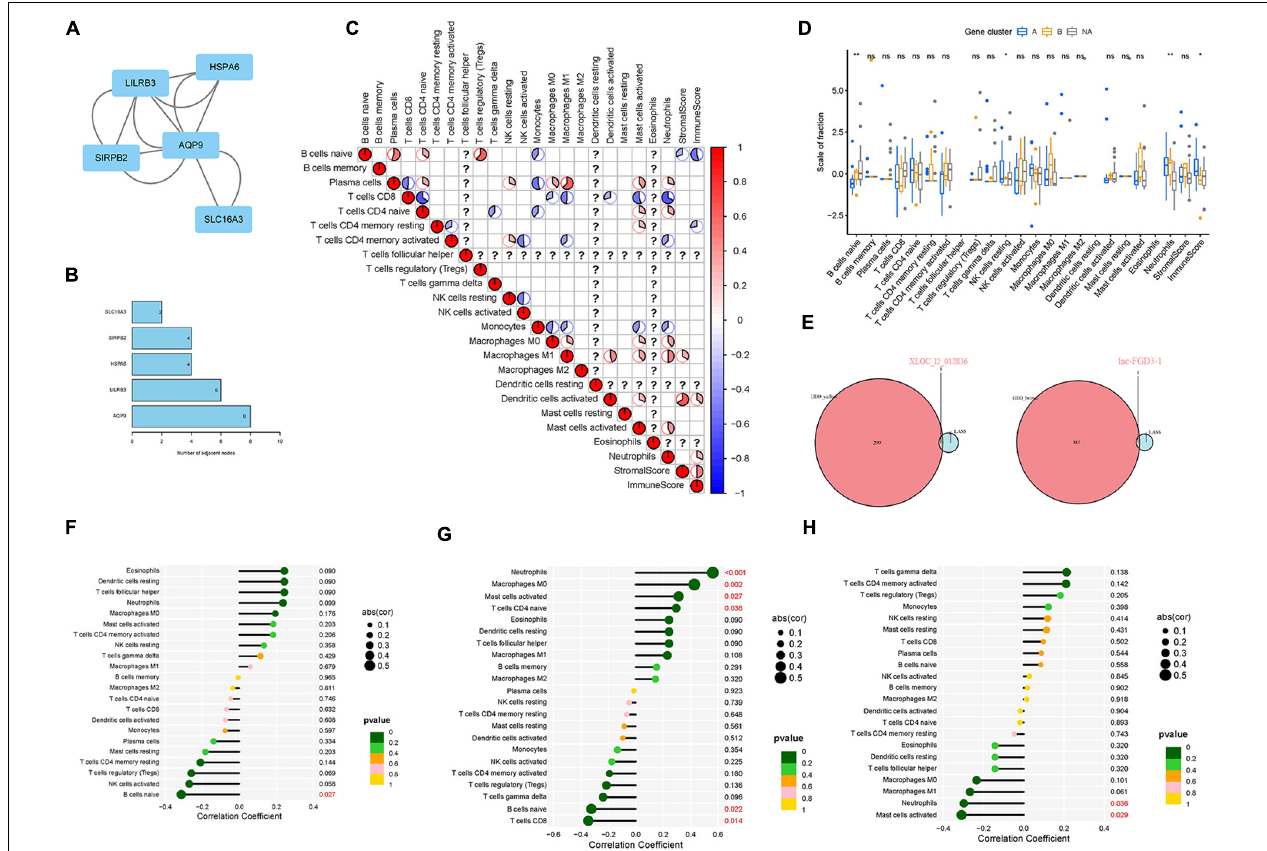
FIGURE 6 | Identification of the hub genes in LDH and verification of the correlation between diagnostic biomarkers and immune cell infiltration. (A) The protein-protein interaction (PPI) network was constructed to identify the hub genes; (B) The number of adjacent nodes correlated with protein of hub genes; (C) analysis of the relationship between 22 types of immune cells of DEGs in LDH; (D) box plot: identification of significant immune cells between normal groups and LDH group (symbol “*,” “**,” and “ns,” respectively, stand for p -value under.05, p -value under.01, and non-significance.); (E) Venn plot: identification of intersection genes between biomarkers and module genes; (F) Expression level correlation between lnc-FGD3-1 and infiltrating immune cells; (G) Expression level correlation between XLOC_l2_012836 and infiltrating immune cells. (H) Expression level correlation between SCARA5 and infiltrating immune cells (The larger the circle size, the stronger the correlation; The color of the dots represents the p -value, and p < 0.05 was considered statistically